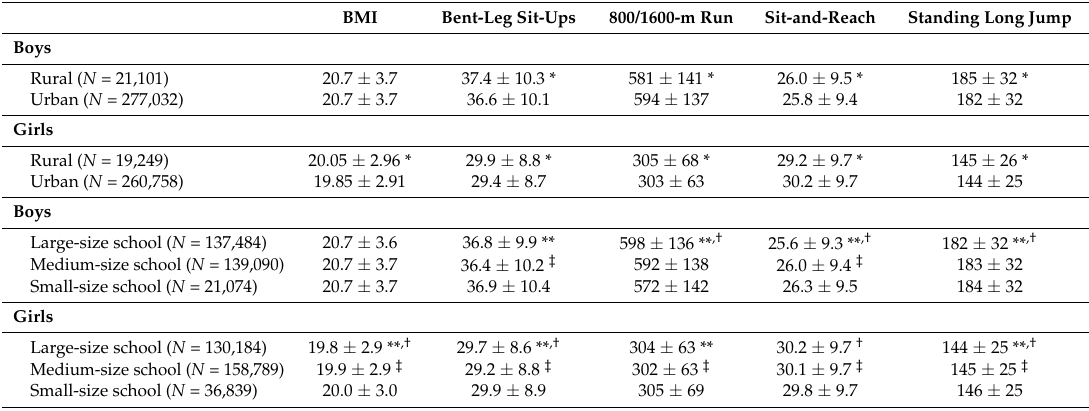
Table 2. Health-related physical fitness measurements for participants, grouped according to urbanization and school size.